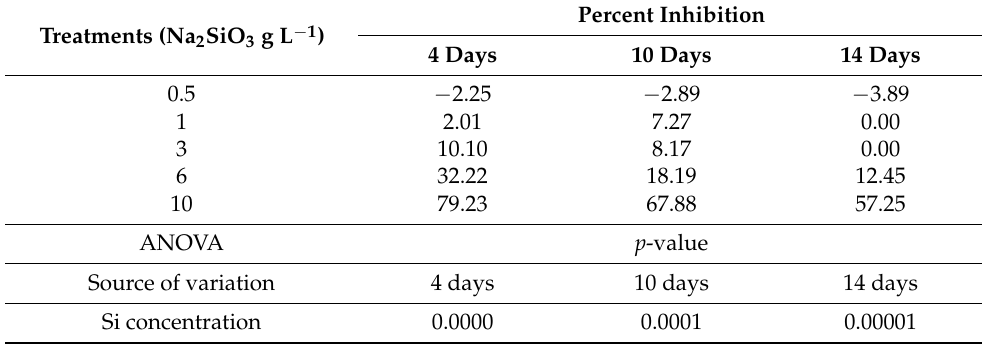
Table 2. In vitro inhibition of the growth of Calonectria ilicicola at different concentrations of Na 2 SiO